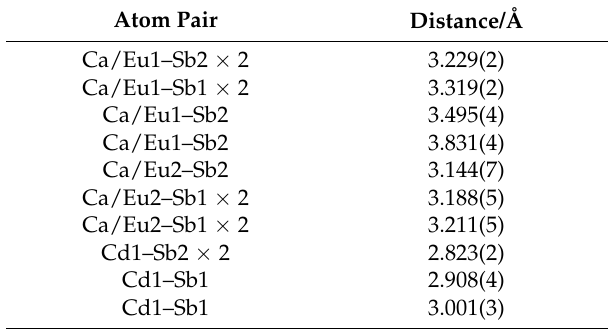
Table 6. Selected interatomic distances for Ca 2 − x Eu x CdSb 2 , x =